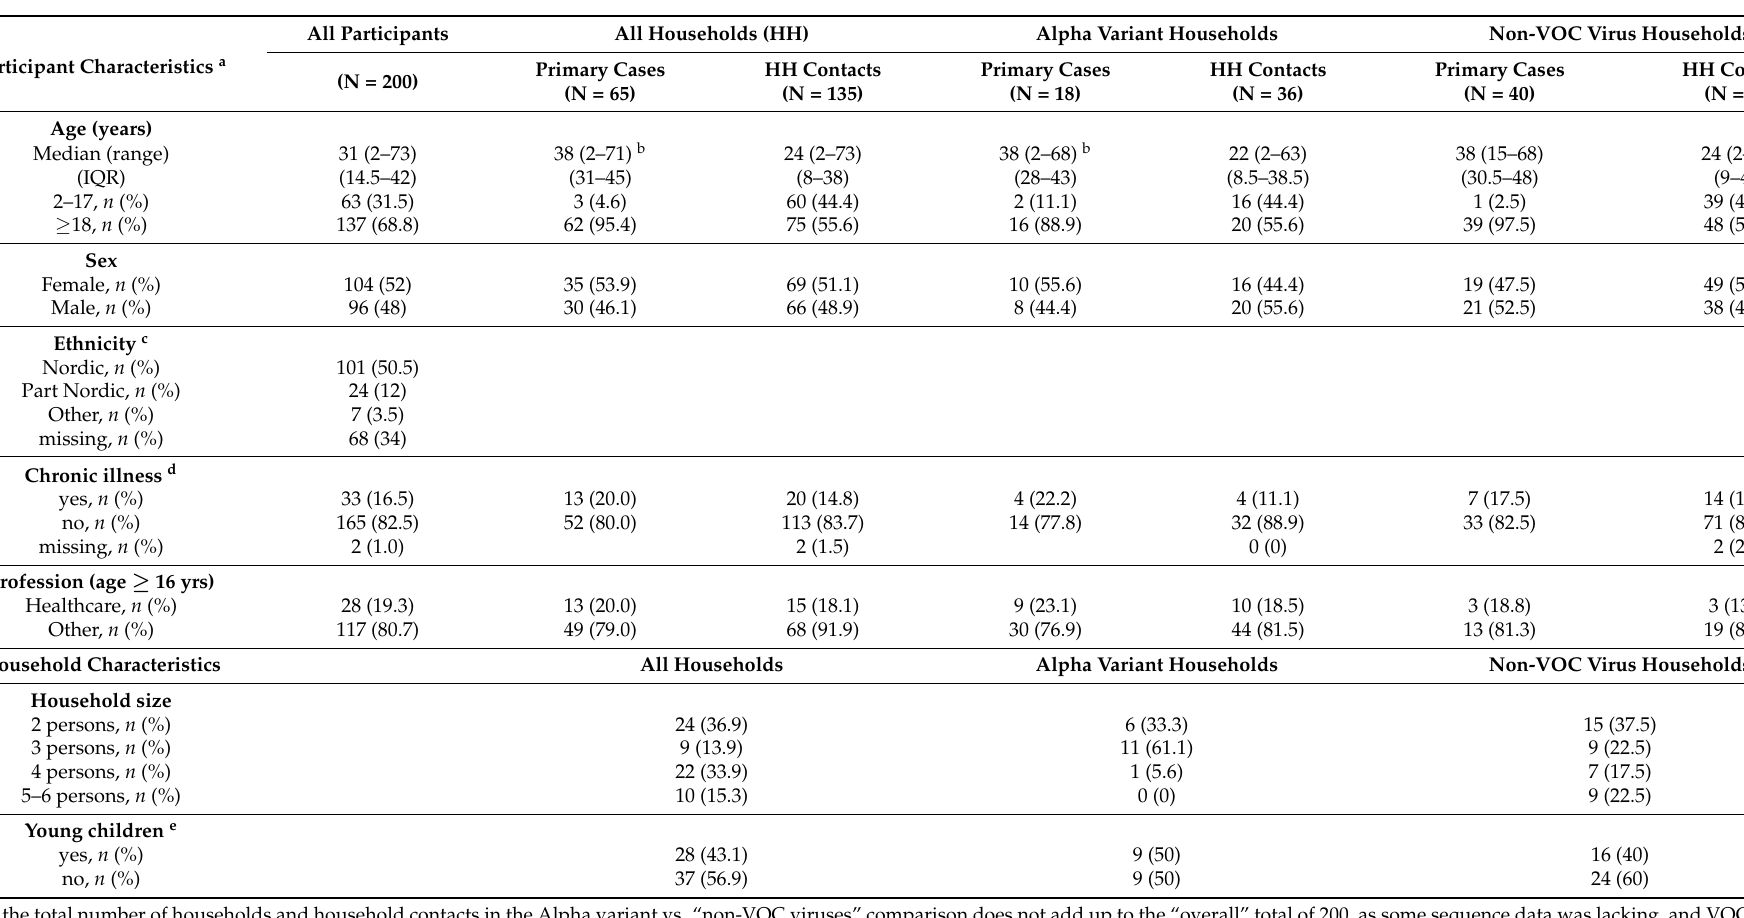
Table 1. Demographic and clinical characteristics of all included participants and households, and Alpha variant and non-VOC virus